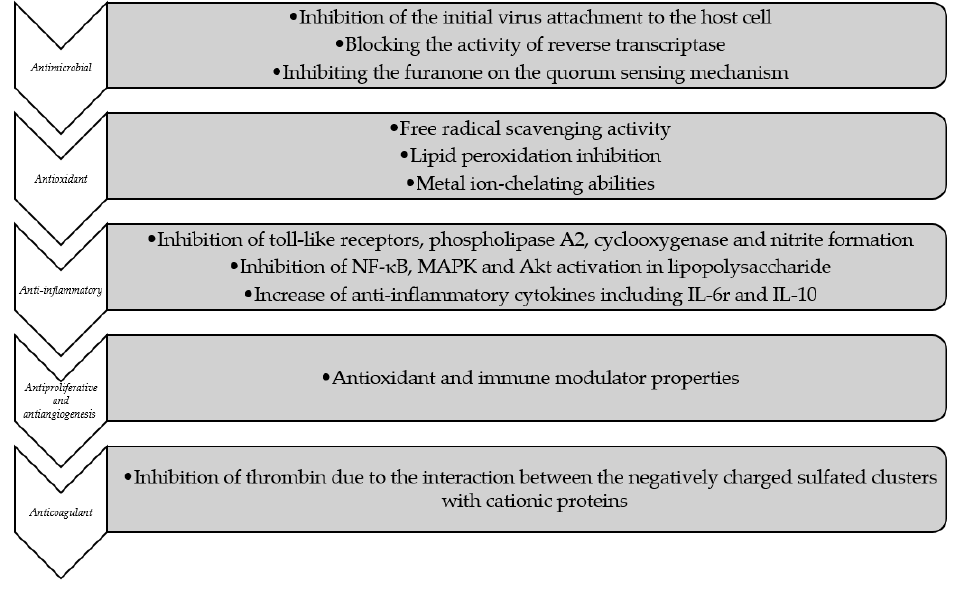
Figure 7. In vitro mechanism of the action of bioactive compounds isolated from seaweeds.